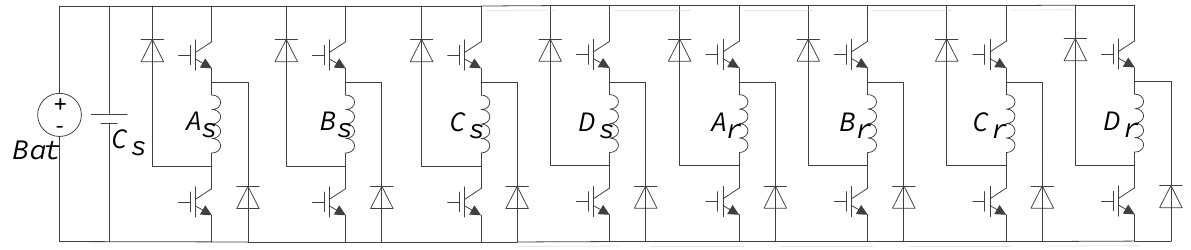
Figure 7. The main power circuit of SRDRM.